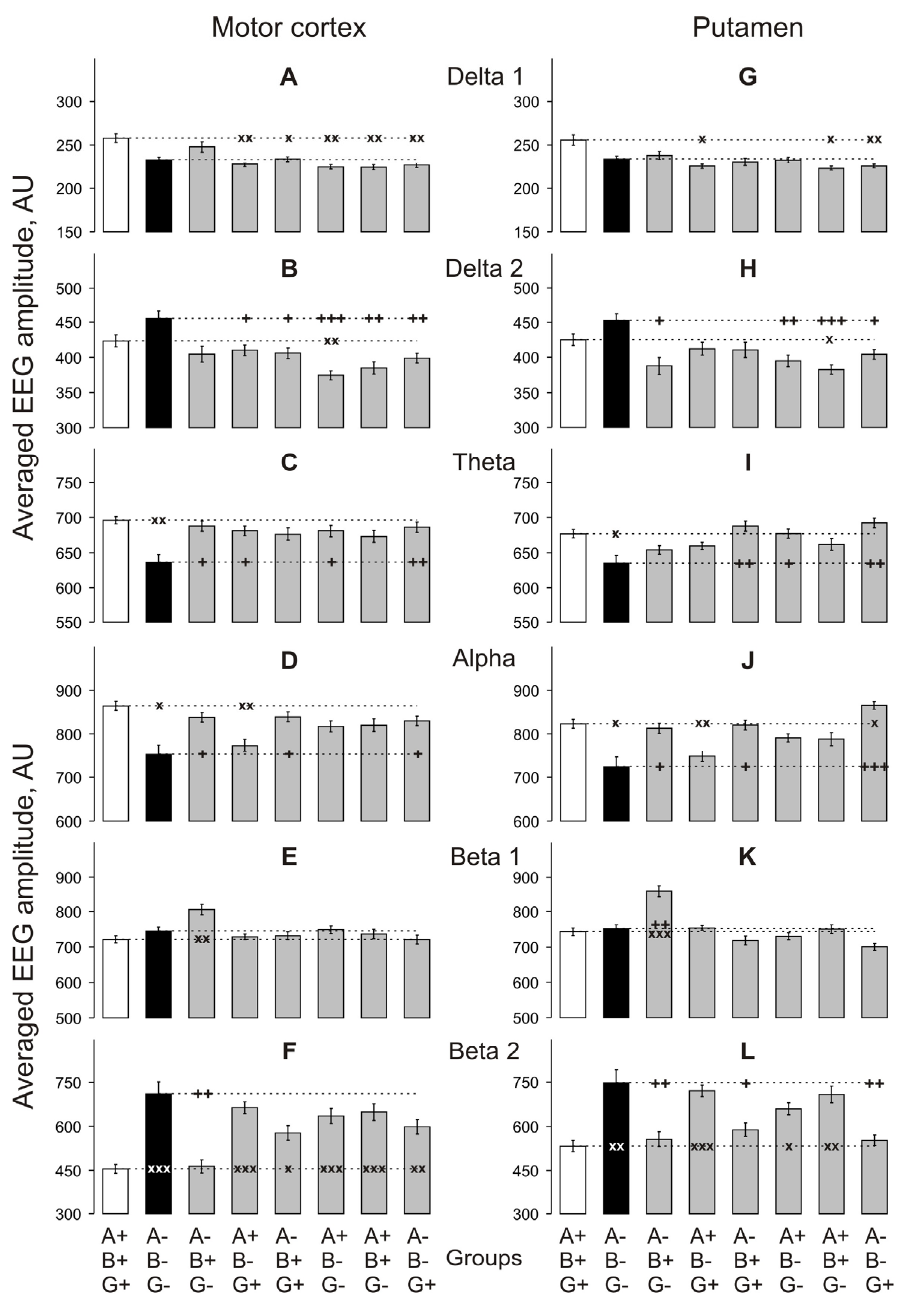
Figure 3. Relations between averaged amplitudes in “classical” frequency bands of 12 s baseline EEG fragments recorded from the motor cortex ( A – F ) and putamen ( G – L ) for 30 min in knockout mice of different types denoted on the horizontal axes. Ordinate is the averaged absolute values of EEG amplitudes in each of the “classical” bands, in arbitrary units (vertical lines are ± 1 SEM). Horizontal dashed lines denote the values in wild-type and triple-knockout groups: x and + symbols denote significant two-way ANOVA differences from the wild-type and triple-knockout mice, respectively (one, two and three symbols denote p < 0.05, <0.01 and 0.001, respectively).